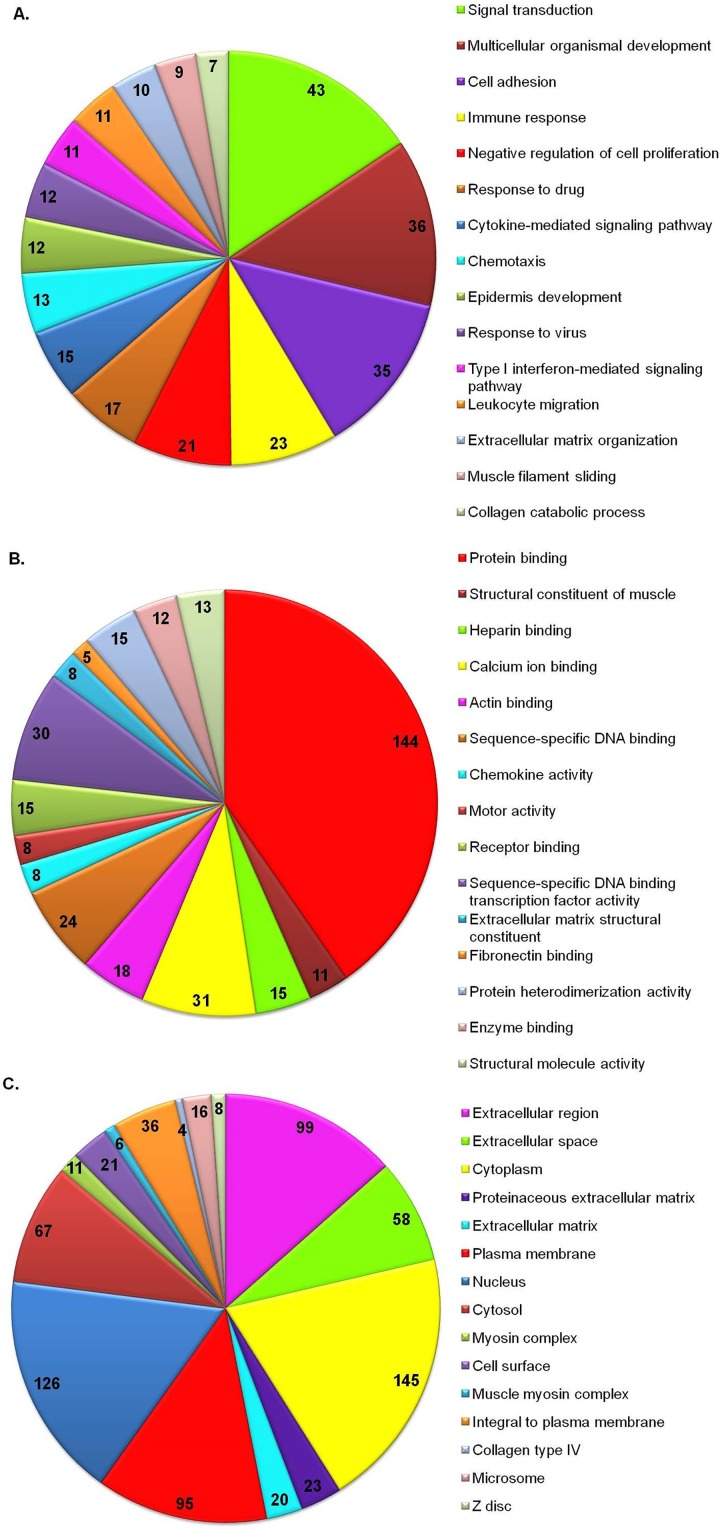
Top 15 enriched GO terms of DEG (A) Biological processes for DEG (P value = 3.57 E-05), (B) Molecular function for DEG (P value = 2.18E-04), (C) Cellular components for DEG (P value = 1.43E-05). The numbers indicate the number of genes per annotation. The numbers in pie-chart indicate the total number of annotated DEG for the respective terms.